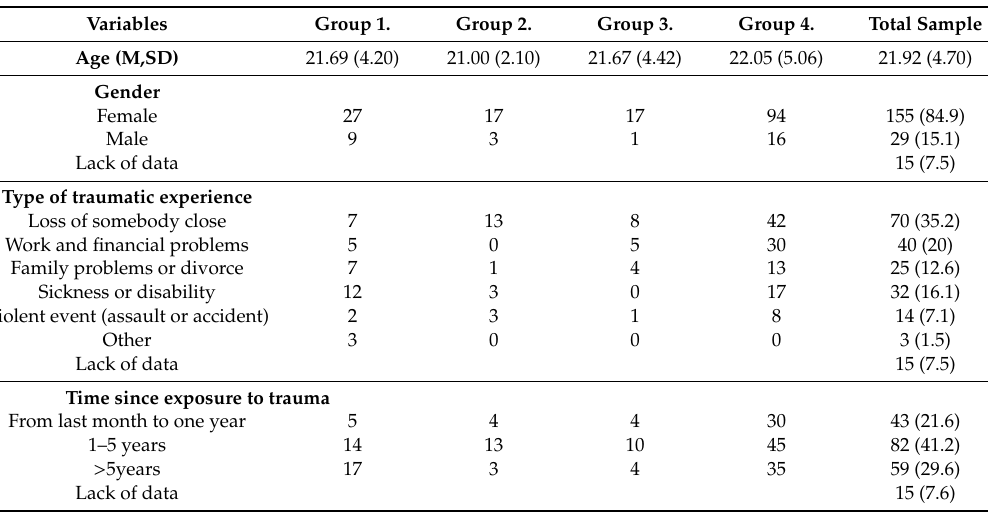
Table 2. Demographic characteristics of the participants ( n =